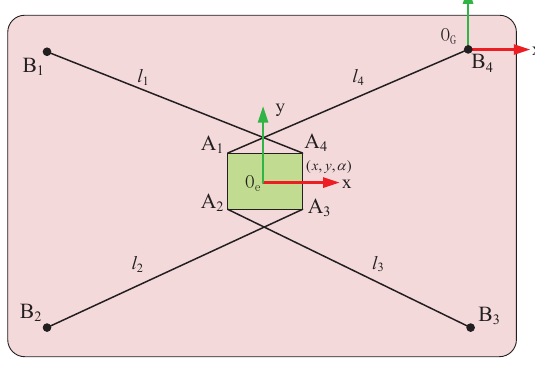
Figure 2. Diagram of the 3-DOF planar